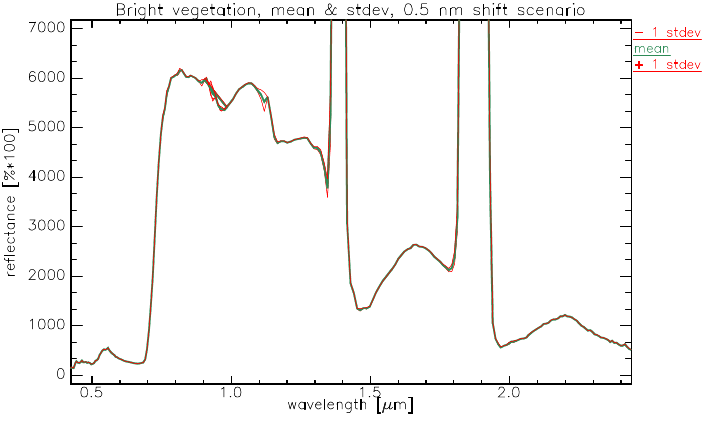
Figure 13. Plot of the mean spectrum and the standard deviation (stdev) calculated over all realisations for the ROI “bright